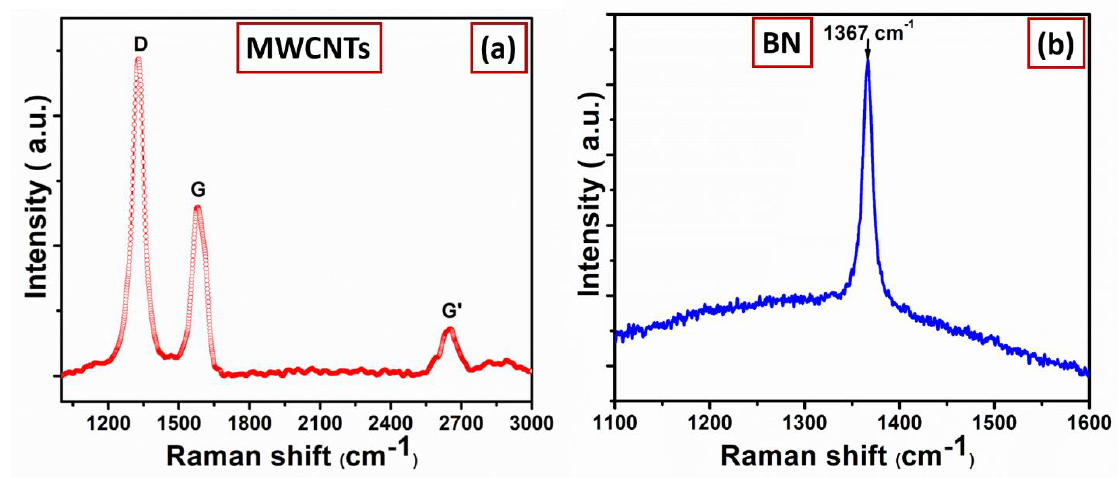
Figure 4. Room-temperature Raman spectrum of ( a ) MWCNTs and ( b ) BN.